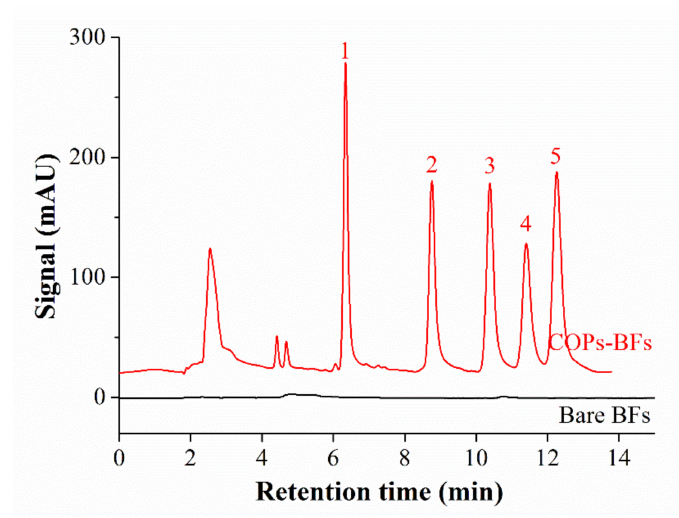
Figure 4. High-performance liquid chromatography (HPLC) chromatograms of 5 µ g / L of standard samples after the extraction between the bare basalt fibers (BFs) tube and basalt fibers functionalized with covalent organic porous polymers (COPs-BFs) tube. Peaks: (1) bisphenol A, (2) 17 α -ethylestradiol, (3) estrone, (4) diethylstilbestrol, (5) hexestrol. Conditions: sampling volume, 60 mL; sampling rate, 1.50 mL / min; methanol content in sample, 1.0% ( v / v ); desorption time, 2.0 min; detection